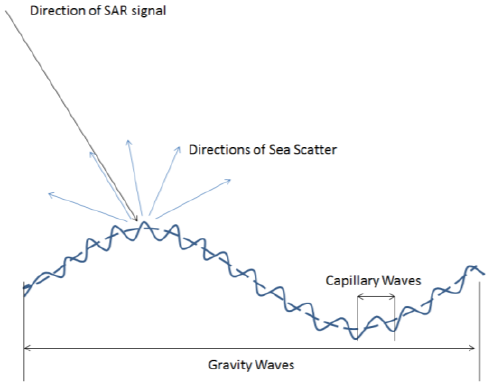
Figure 1. Demonstration of radar scattering from the sea surface.